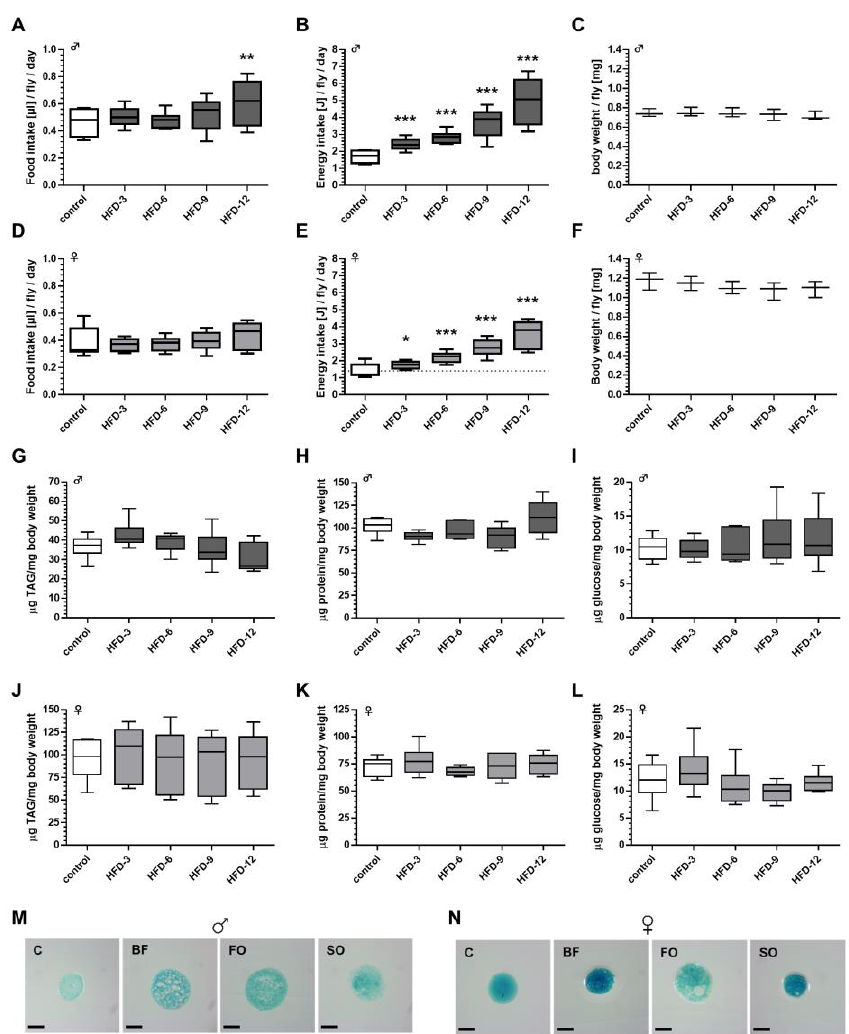
Figure 7. Short-term consumption of a high-fat diet (HFD) with different fat qualities significantly increased the energy intake of both male and female D. melanogaster while body composition was solely altered in female flies. D. melanogaster w 1118 flies were fed ad libitum with the indicated exper- imental diets for 5 – 7 days. Food was renewed 3 times a week and the flies were kept under standard conditions throughout experimental treatment. Food intake was examined by EX-Q. ( A ) In males, the food intake was increased by ingestion of an HFD-BF, HFD-OO, HFD-LO or HFD-FO, ( D ) while in females, it was elevated in response to an HFD-SO, HFD-OO or HFD-LO. The corresponding calculated total energy intake was significantly enhanced in all males ( B ) and females ( E ) that re- ceived an HFD ( n = 3 replicates with N = 225 animals per treatment). ( C ) The body weight of males was not altered by any diet , ( F ) while that of females was significantly reduced following intake of